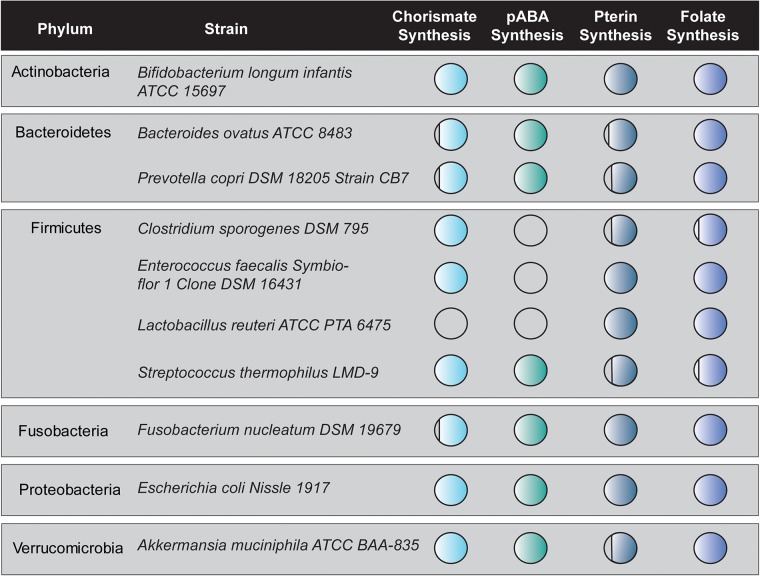
In silico analysis of folate synthesis gene distribution in an intestinal microbe cohort. The Joint Genomes Institute (JGI) Profile and Alignment Tool was used to predict chorismate synthesis genes, pABA synthesis genes, pterin synthesis genes, and folate synthesis genes in a cohort of 10 strains representing six phyla of the human intestinal microbiome. The circles are filled in proportion to the number of those genes contained in the genome of each bacterial strain. Circles 90% filled represent one missing gene while circle 75% filled represent two missing genes.